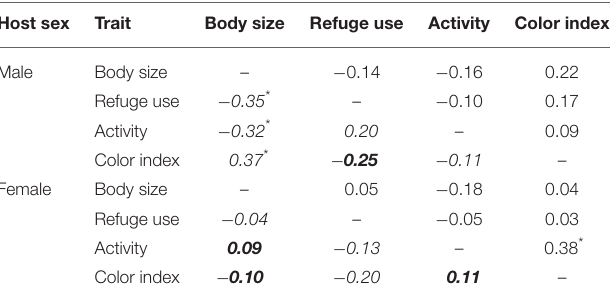
Trait-pairs in which both traits were modified individually ( Table 2 ) are shown in bold. Upper diagonals for each group show values for the uninfected individuals and lower diagonals (in italics) show values for infected individuals. * Indicates that the correlation was significant at the 0.05 level. Correlation analysis using principal component values for color (PC1) yielded similar relationships to those shown for the color